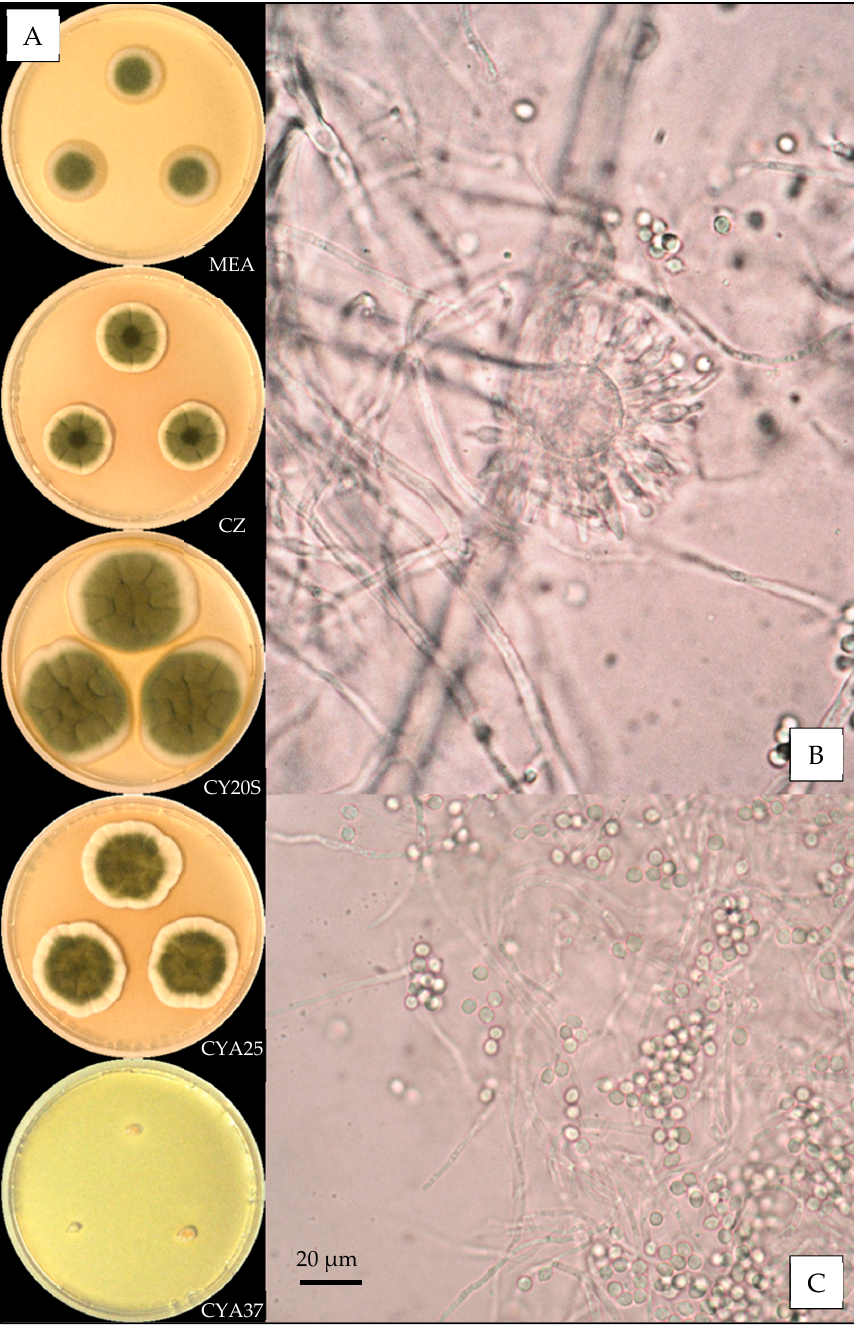
Figure 2. Aspergillus amoenus : ( A ) from top to bottom, colonies on MEA, CZ, CY20S, CYA25 and CYA37, 14 days. ( B ) Conidial head and ( C ) conidia (1000×).